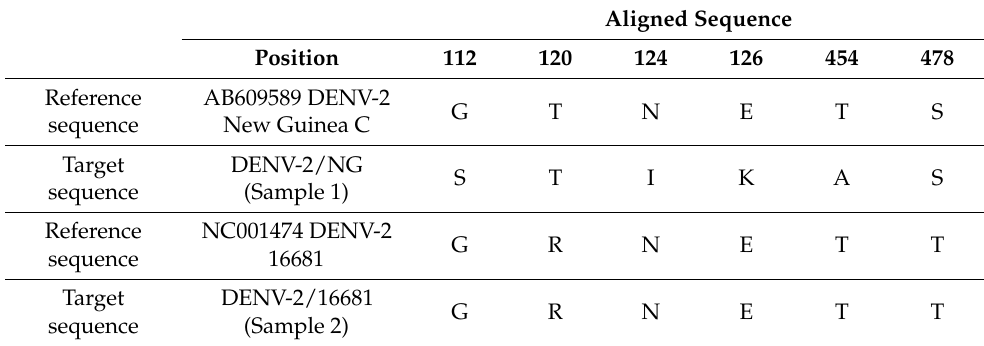
Table 1. Amino acid changes in the envelope gene of the DENV-2/NG and DENV-2/16681 strains.